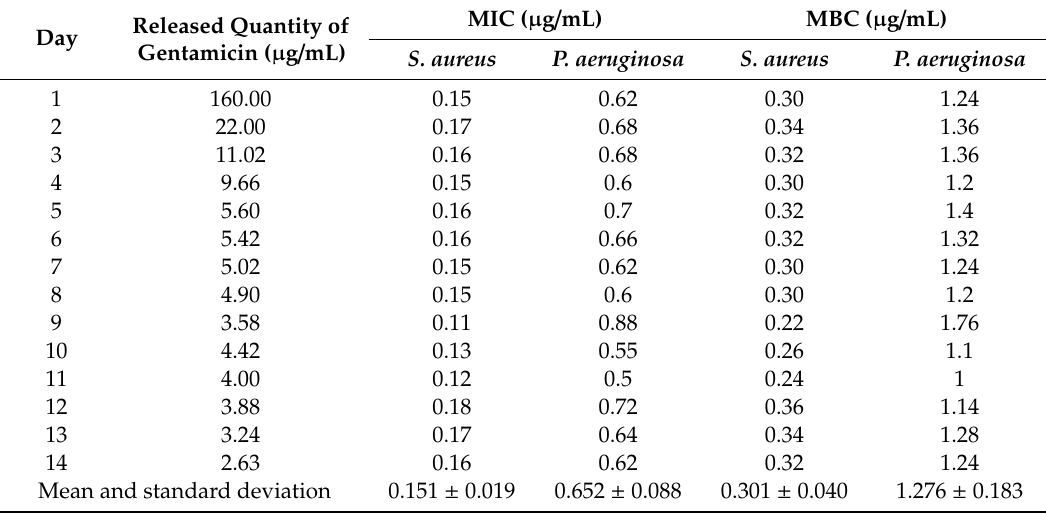
Table 3. Daily determination of MIC and MBC for the extracts obtained from pill